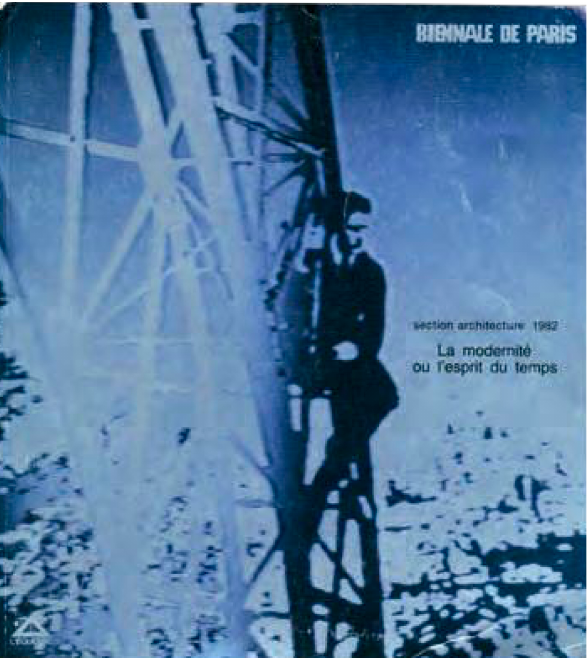
Figure 2. Front cover of the exhibition catalogue Jean Nouvel, Anne Laure Egg, Odile Fillion, Patrice Goulet, eds. 1982. La Modernit é ou l’esprit du temps . Paris: l’ É